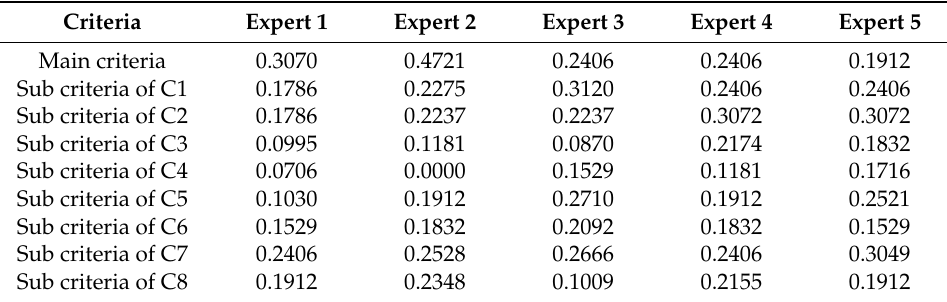
Table 4. The consistency for all